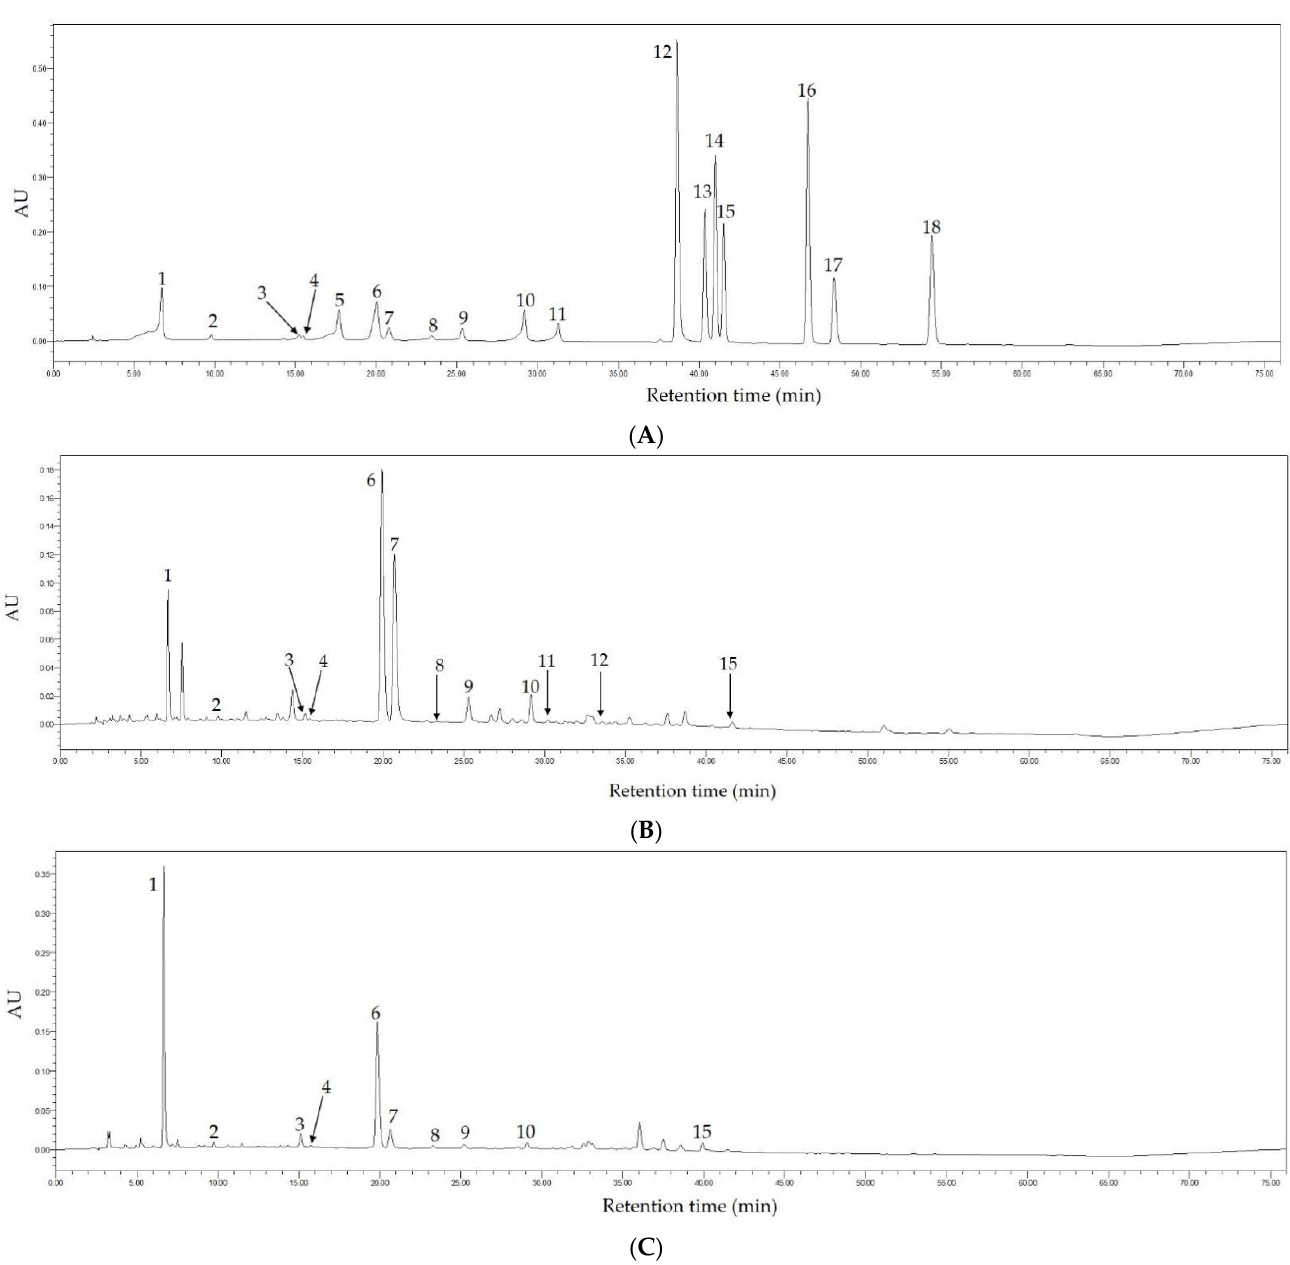
Figure 11. The HPLC chromatograms of the standard compounds ( A ), Fenghuang Danzong Tea ( B ), and Selenium-Enriched Dark Tea ( C ) under 254 nm. 1, gallic acid; 2, gallocatechin; 3, epigallocatechin; 4, catechin; 5, chlorogenic acid; 6, caffeine; 7, epigallocatechin gallate; 8, epicatechin; 9, gallocatechin gallate; 10, epicatechin gallate; 11, catechin gallate; 12, ellagic acid; 13, myricetin; 14, quercitrin; 15, astragalin; 16, quercetin; 17, theaflavin; 18, kaempferol.